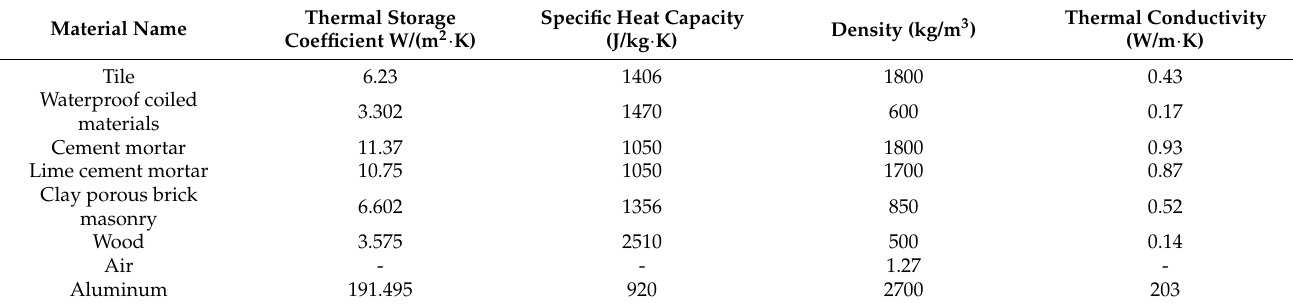
Table 2. Related properties of the building